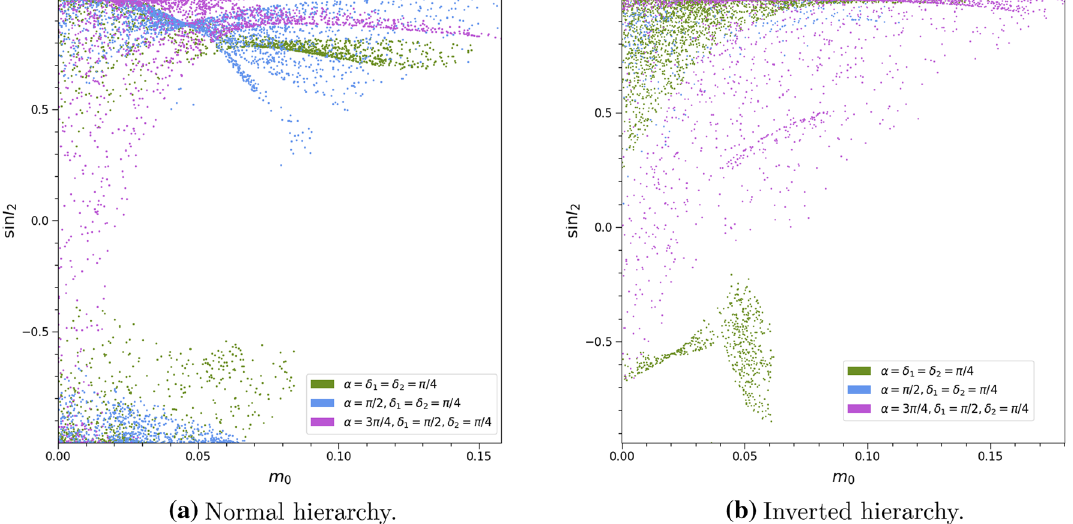
Fig. 9 sin I 2 as a function of the lightest neutrino mass m 0 for non-zero Majorana